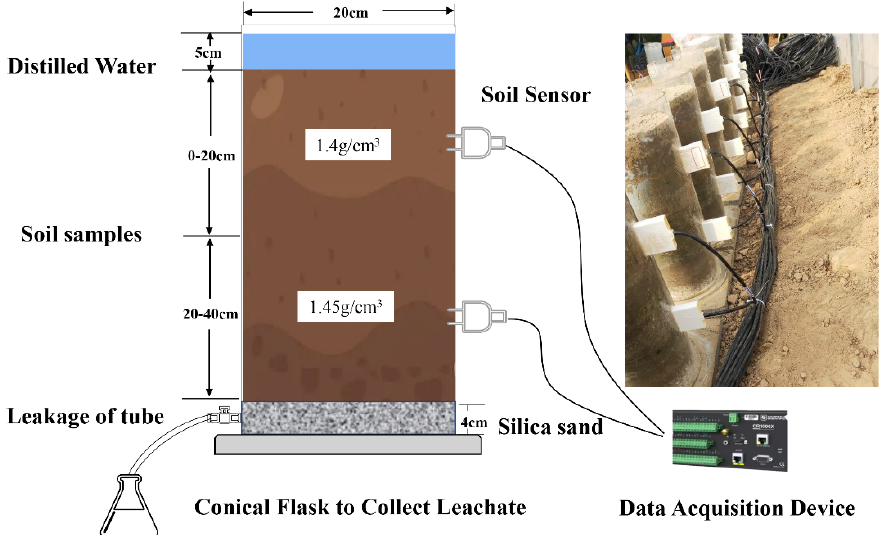
Figure 1. Design diagram of soil column experiment.